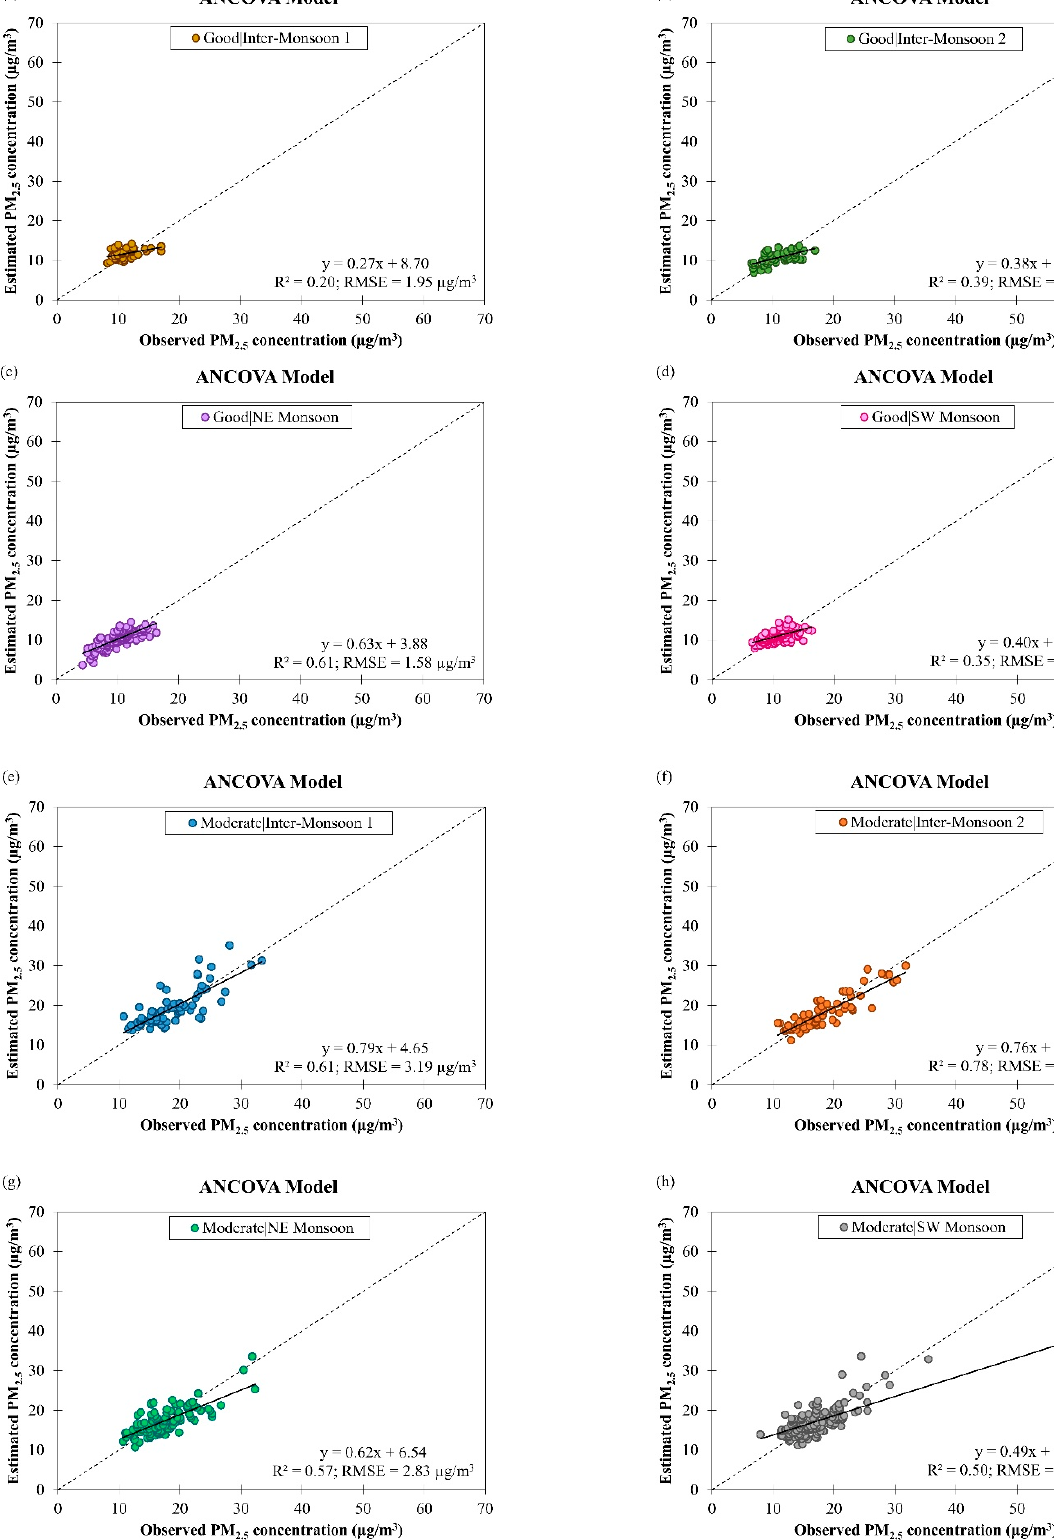
Figure 7. Scatter plots of estimated daily PM 2.5 concentration against observed daily PM 2.5 concen- tration by ANCOVA model for ( a – d ) good and ( e – h ) moderate air quality conditions during different monsoon seasons in Singapore from March 2016 to February 2018.